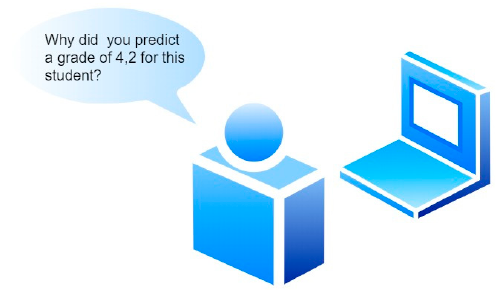
Figure 1. Why was a specific prediction was made by the model?